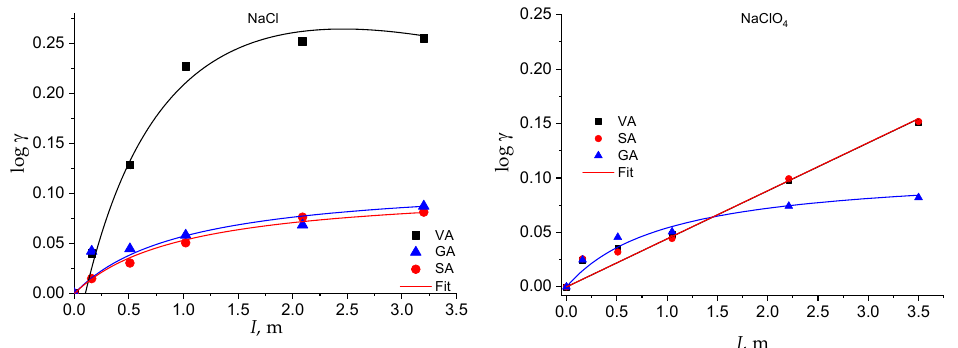
Figure 4. log γ of the hydroxybenzoic acids as a function of the solvent salt and of the ionic strength.